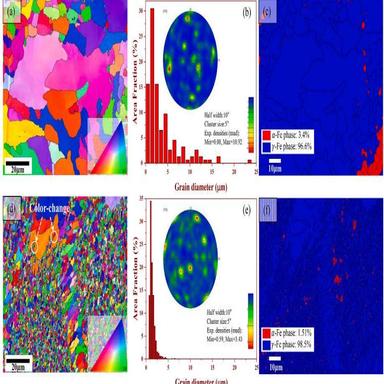
EBSD analysis of plain stainless steel and its nanocomposite doped with 2.5 vol% of TiB2 nanoparticles: (a) and (d) inverse pole figure (IPF) maps on the surface of pore-gradient materials, (b and e) their grain size distributions and (c and f) phase distribution.